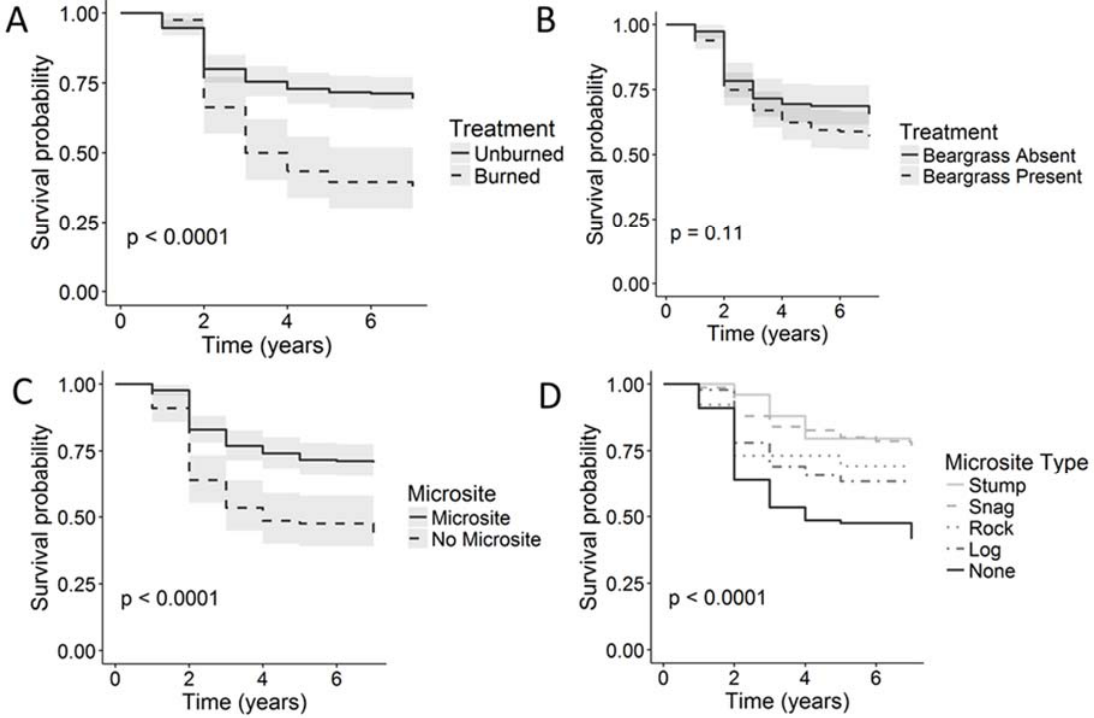
Figure 4. Seedling cluster survival over time. ( A ). on burned and unburned areas X 2 (1, n = 331) = 27, p ˂ 0.0001. ( B ). with and without beargrass X 2 (1, n = 331) = 2.6, p = 0.11. ( C ). with and without microsite X 2 (1, n = 331) = 27.4, p ˂ 0.0001. ( D ). famong microsite (shelter object) types X 2 (3, n = 219) = 5.4, p =0.143, but is the same as C between “None” and “Present”.